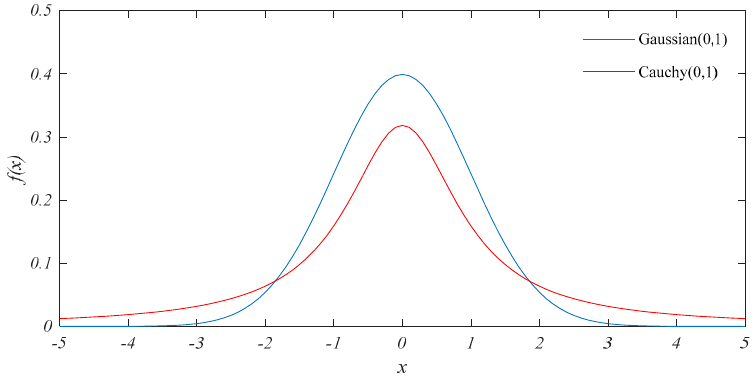
Figure 2. Gaussian and Cauchy distributions.